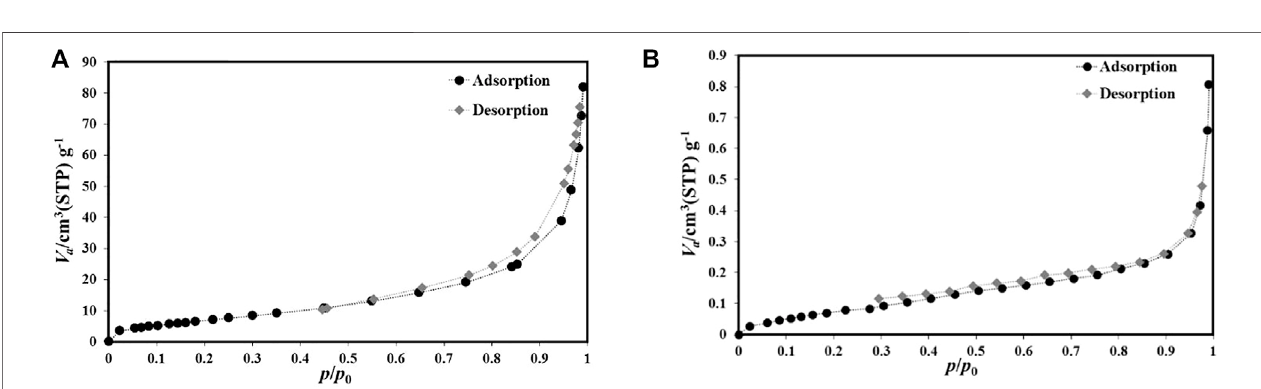
FIGURE 6 | BET technique of the N 2 adsorption/desorption isotherms of (A) S1 and (B) S2 samples.